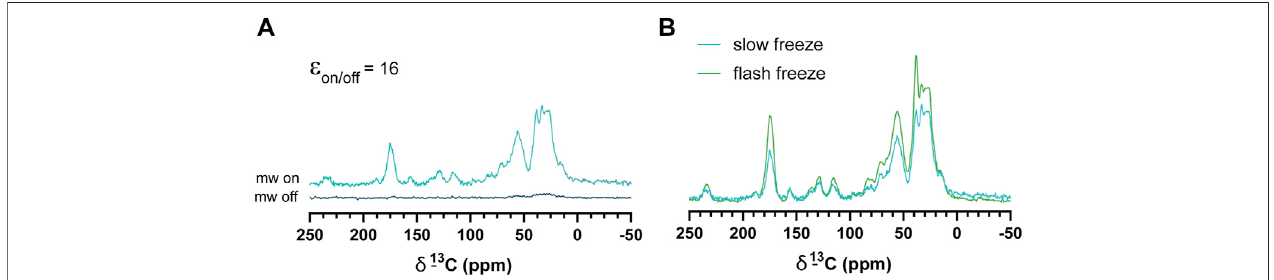
FIGURE 6 | DNP enhancements of slow-frozen cells. (A) 1 H- 13 C CP spectra of slow-frozen Jurkat T cells preserved with 10% DMSO. The enhancement given is the peak intensity ratio of the carbonyl resonance. (B) Comparison of microwave on spectra from slow-frozen cells in 10% DMSO (dark teal line) to fl ash-frozen cells in 10% DMSO (green line). DNP experiments were carried out at 600 MHz 1 H larmor frequency at 9 kHz MAS.